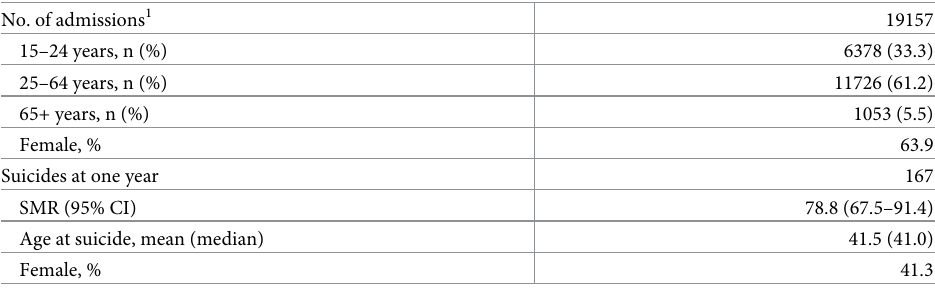
Table 3. Hospital-admissions for intentional self-harm selected using external cause information, Victoria, 2011 to